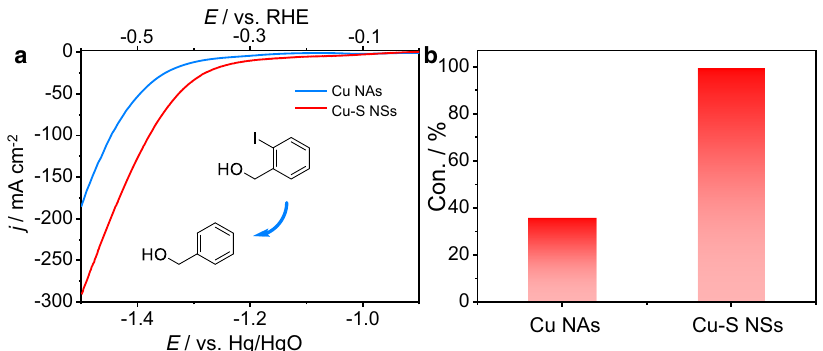
Fig. 7 Performances of Cu NAs with and without adding Na 2 S for the hydrodehalogenation of 2-iodobenzyl alcohol. a LSV curves of Cu NAs with and without adding Na 2 S for the hydrodehalogenation of 2-iodobenzyl alcohol in 1.0 M KOH. b Con. of 2-iodobenzyl alcohol over Cu NAs cathode with and without S 2 −